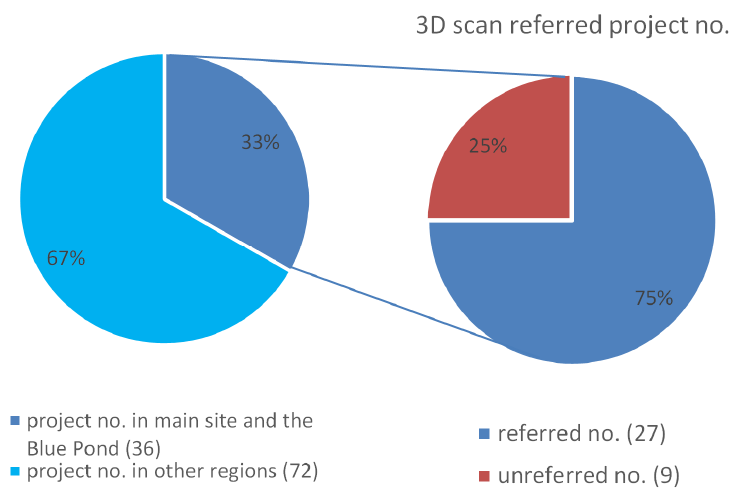
Figure 9. ( a ) Scanned boundaries, ( b ) 3D-point-cloud model in the main area with lanterns and facilities labeled alphabetically, ( c ) segmented parts, ( d-1 ) the Blue Pond and the set of lotus lanterns on plan view, and ( d-2 ) lanterns on elevation view.